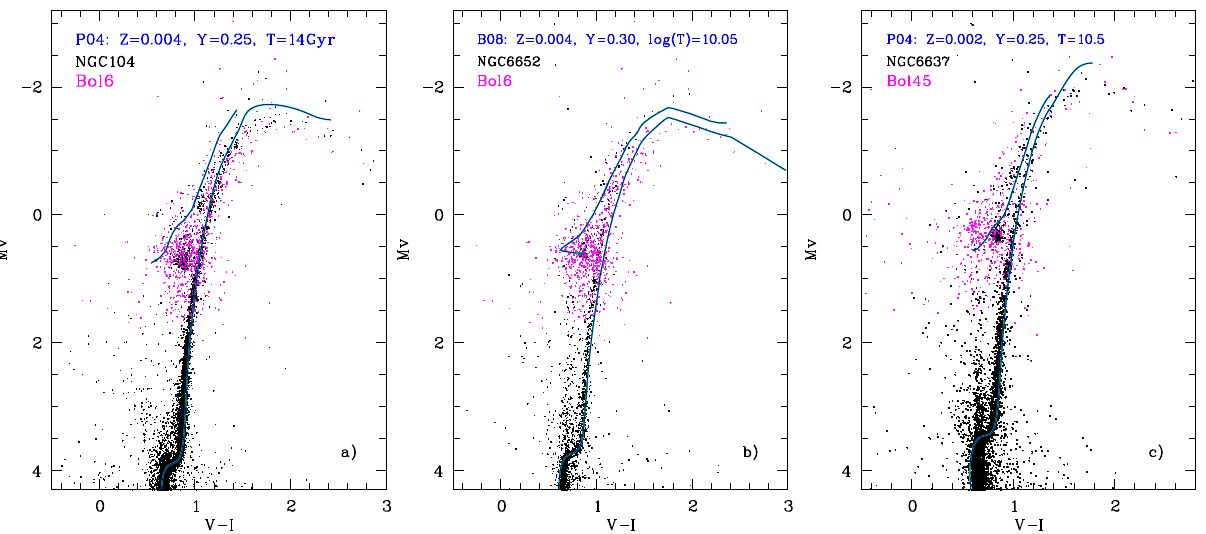
Figure 1: CMDs for Bol 6 ( panels a and b ) and Bol 45 ( panel c ) ( Federici et al . 2012 ) ( magenta dots ) in comparison with the CMDs of Galactic GCs ( Sarajedini et al . 2007 ) NGC 104, 6652 and 6637 ( black dots ) and with the evolutionary isochrones ( green lines ) by Bertelli et al . ( 2008 ) for Bol 6 ( panel b ) and Pietrinferni et al . ( 2004 ) for Bol 6 ( panel a ) and for Bol 45 ( panel c ) , selected by MMI21 for the analysis of the IL spectra of the